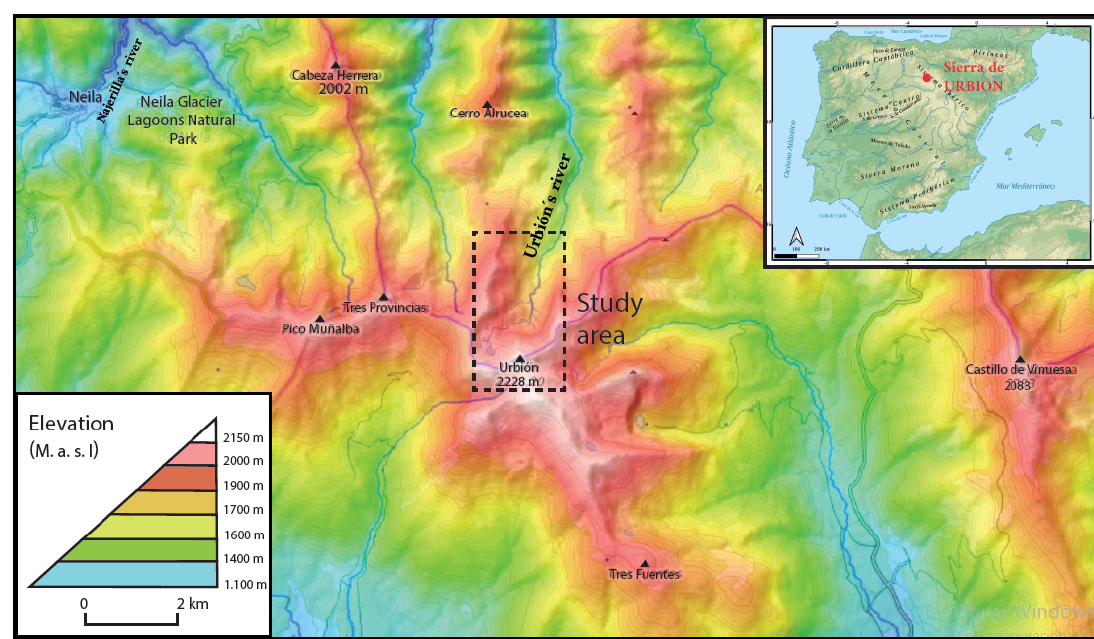
Figure 1. Location of the Picos de Urbión and the Urbión river valley. Location of specific study area.